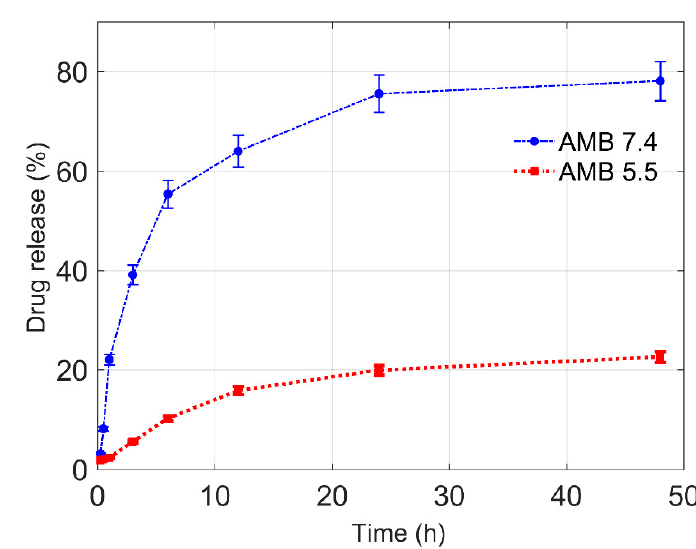
Figure 5. Amp B drug release profile from the prepared polymeric nanoparticle in phosphate buffer at different pH values of 7.4 and 5.5.